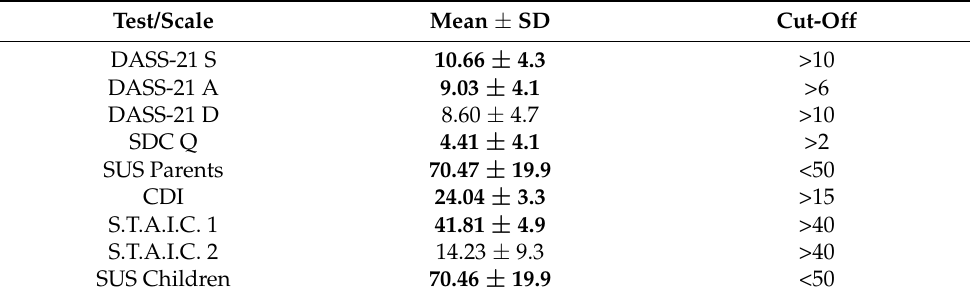
Table 2. Average of the clinical scale of